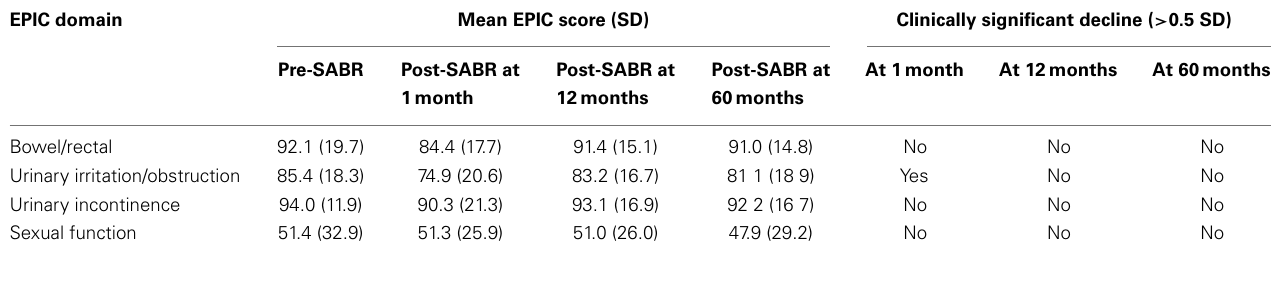
Table 2 | Pre- and post-treatment EPIC scores